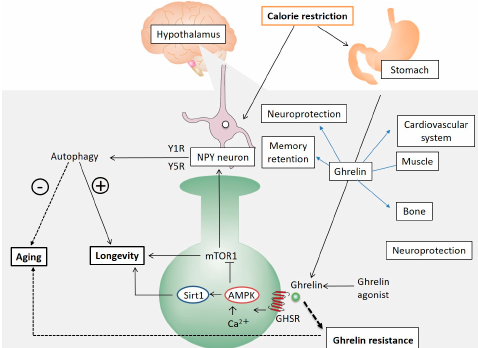
Figure 1. CR increases the expression of hypothalamic AgRP and NPY and reduces the expression of POMC. NPY promotes autophagy in the hypothalamus. Ghrelin also affects the cardiovascular system, muscle, bone, and memory retention, as well as providing a neuroprotective effect, all of which result in an extended life span and anti-aging effects. CR: caloric restriction; AgRP: agouti-related protein; POMC: proopiomelanocortin; NPY: neuropeptide Y.